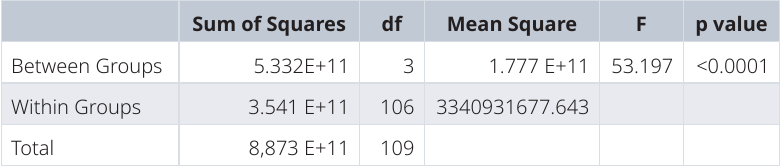
Table 4. Platelets count and esophageal varices relation. Sum of